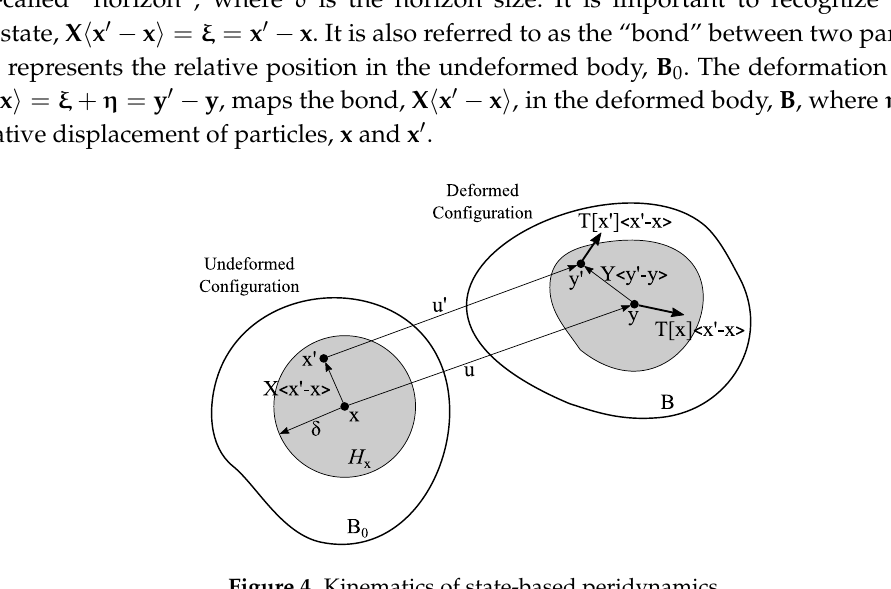
Figure 4. Kinematics of state-based